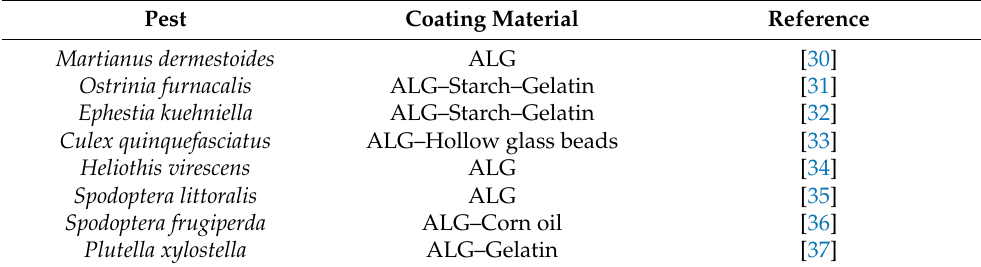
Table 2. Bacillus thuringiensis microcapsules produced with alginate in combination with other polymers.